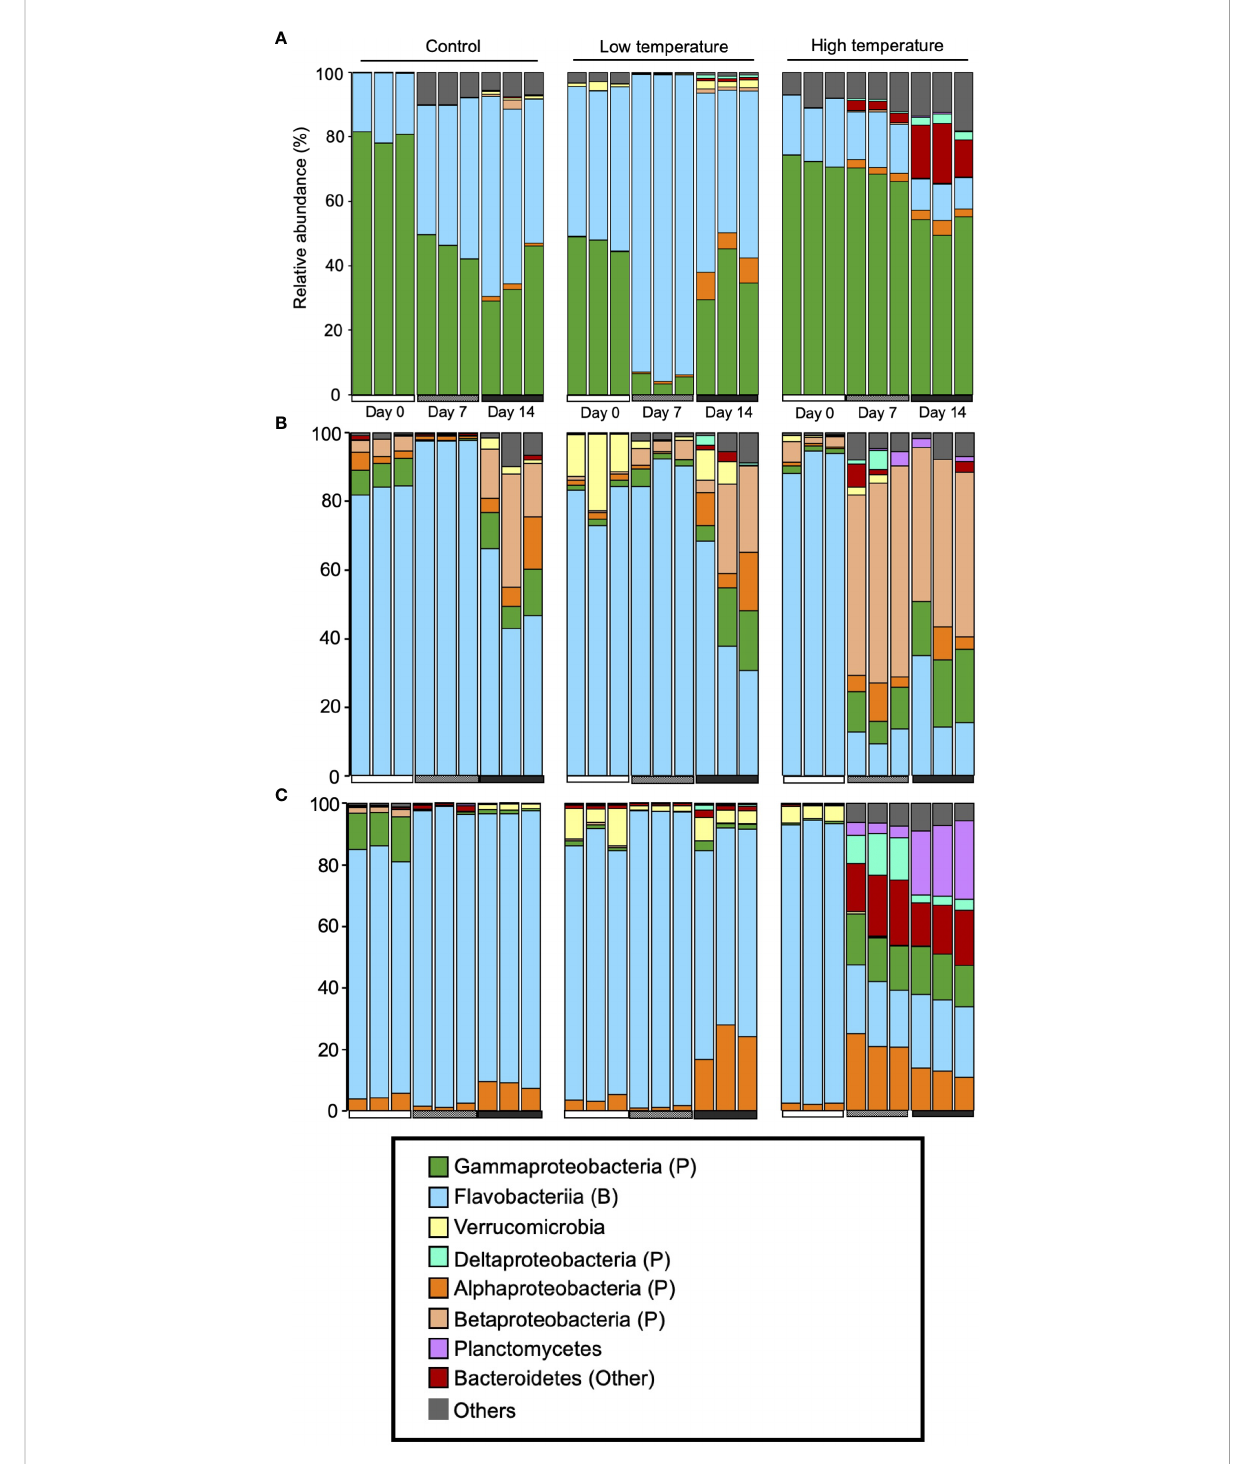
FIGURE 2 Microbial community composition of chum salmon (A) fecal, (B) skin mucus, and (C) surrounding water samples from different temperatures and time points, shown at the phylum level. Results for two phyla, Proteobacteria and Bacteroidetes , are also shown at the class level. Each letter in brackets indicates membership in Proteobacteria (P) or Bacteroidetes (B). Relative abundance is shown as a mean value calculated from three replicates of each sample. Phyla that contributed less than 2% were combined and referred to as “ Others ”